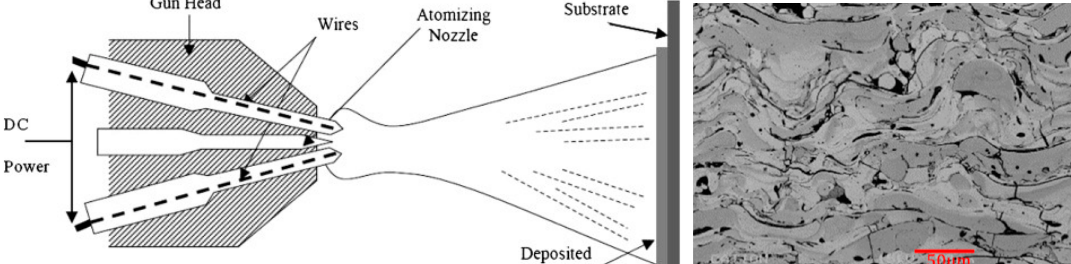
Figure 13. ( a ) Schematic arc wire spray coating setup and mechanism of operation [117]. ( b ) SEM micrograph of arc wire spray-coated surface by Tafa’s steel (95MXC) cored wire feedstock. The substrate material is not mentioned in Reference [114].